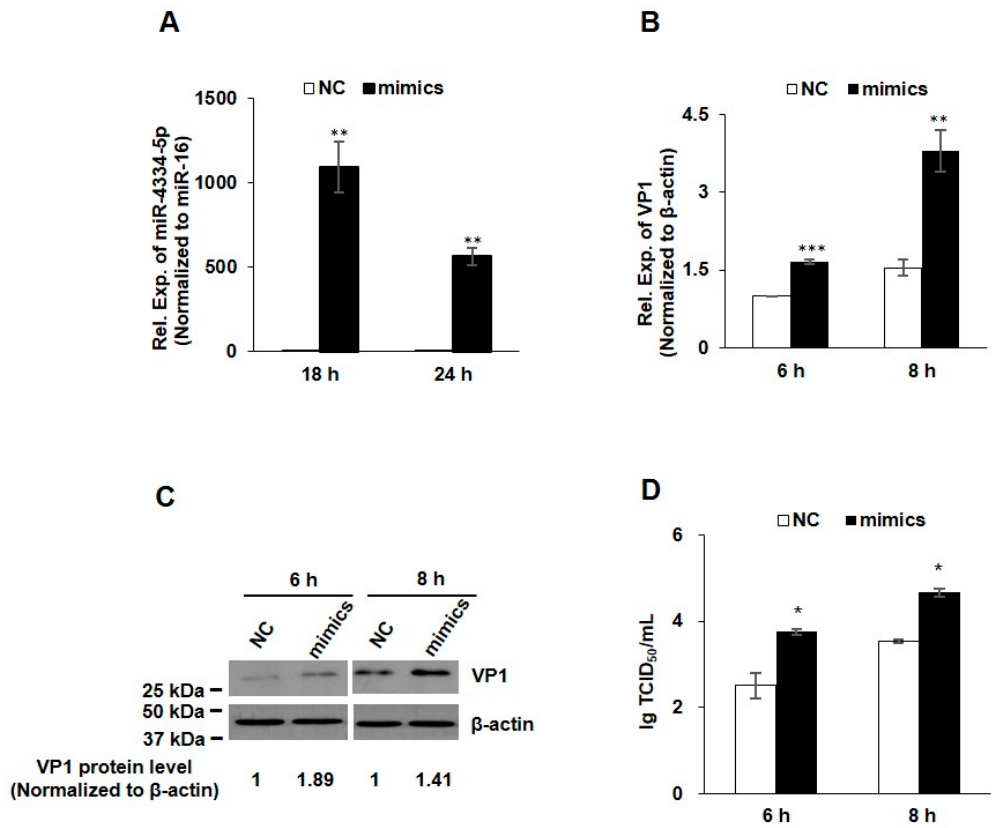
Figure 2. FMDV replication was up-regulated by miR-4334-5p mimics. ( A ). MiR-4334-5p mimics or scramble mimics (NC) were transfected into PK-15 cells for 18 h or 24 h, respectively. Cells were collected and then quantified miR-4334-5p expression by qRT-PCR, and miR-16 was examined as an internal control in parallel. Data shown are means ± SD from triplicate assays, ** p < 0.01. ( B ). MiR-4334-5p mimics or scramble mimics (NC) were transfected into PK-15 cells for 24 h, cells were challenged with FMDV at 0.1 MOI for 6 h or 8 h, and then cells were harvested to quantify VP1 expression by qRT-PCR, and the expression level was normalized to β -actin. The data are means ± SD from triplicate assays, *** p < 0.001; ** p < 0.01 ( C ). PK-15 cells were treated as in ( B ), the cells were lysed and then subjected to Western blot, VP1 and β -actin antibodies were used to detect the protein expression. ( D ). PK-15 cells were treated as in ( B ), after infected with the indicated time, the supernatants were collected to measure the virus titers by TCID 50 (Median Tissue Culture Infectious Dose) assay. Results shown are means ± SD from triplicate assays, * p <